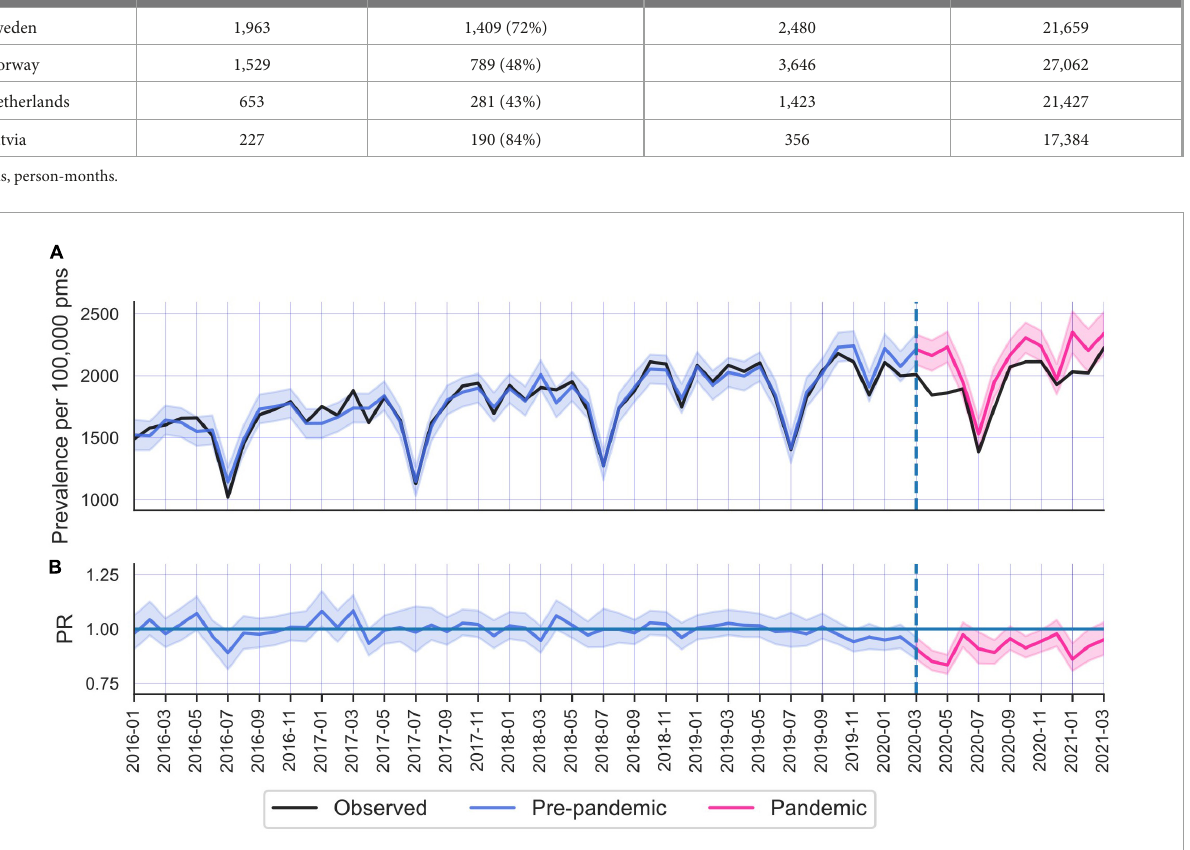
FIGURE1 (A) Number of unique individuals seeking care for depression and/or anxiety. Monthly counts in Sweden between January 2016 and March 2021, all ages and both sexes. Black = actual number; blue = fitted prevalence rates (with 95% confidence interval), pink = predicted prevalence rates (95% CI). (B) Prevalence ratios (i.e., observed over expected) (95% CI). Vertical striped lines indicate onset of pandemic (March 2020) (the first year of this and subsequently presented time series provides unreliable model fits and are omitted for display